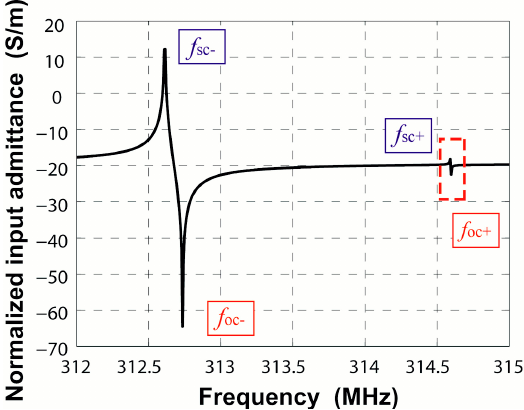
Figure 7. Input admittance of periodic IDT on ST-2°X quartz: the red dashed box area shows the counteracted extrema in Figure 6.